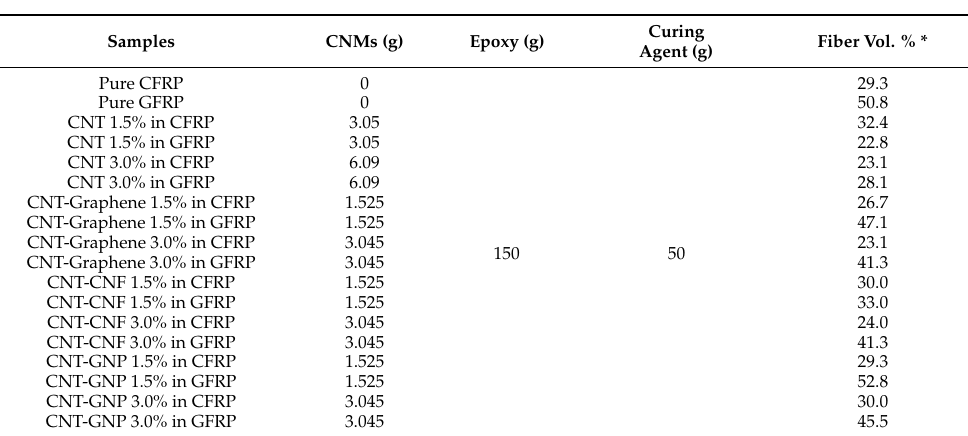
Table 3. Mix proportions of CFRP- and GFRP-based